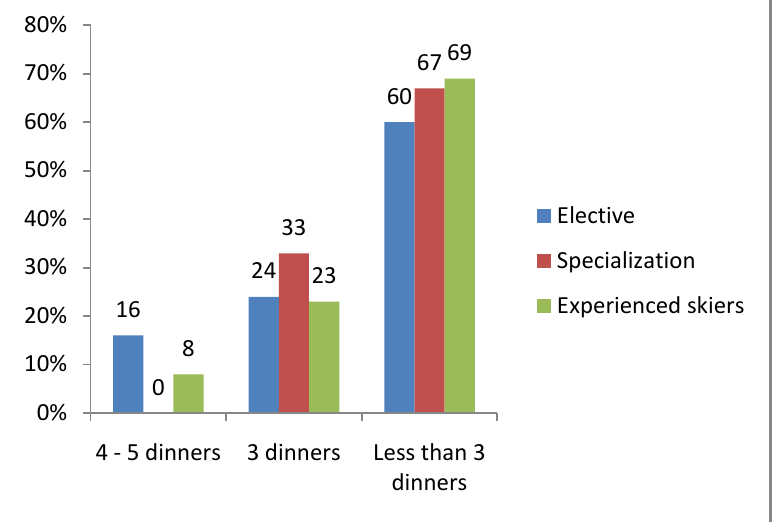
Figure 7. Daily intake of vegetables-juice-fruit